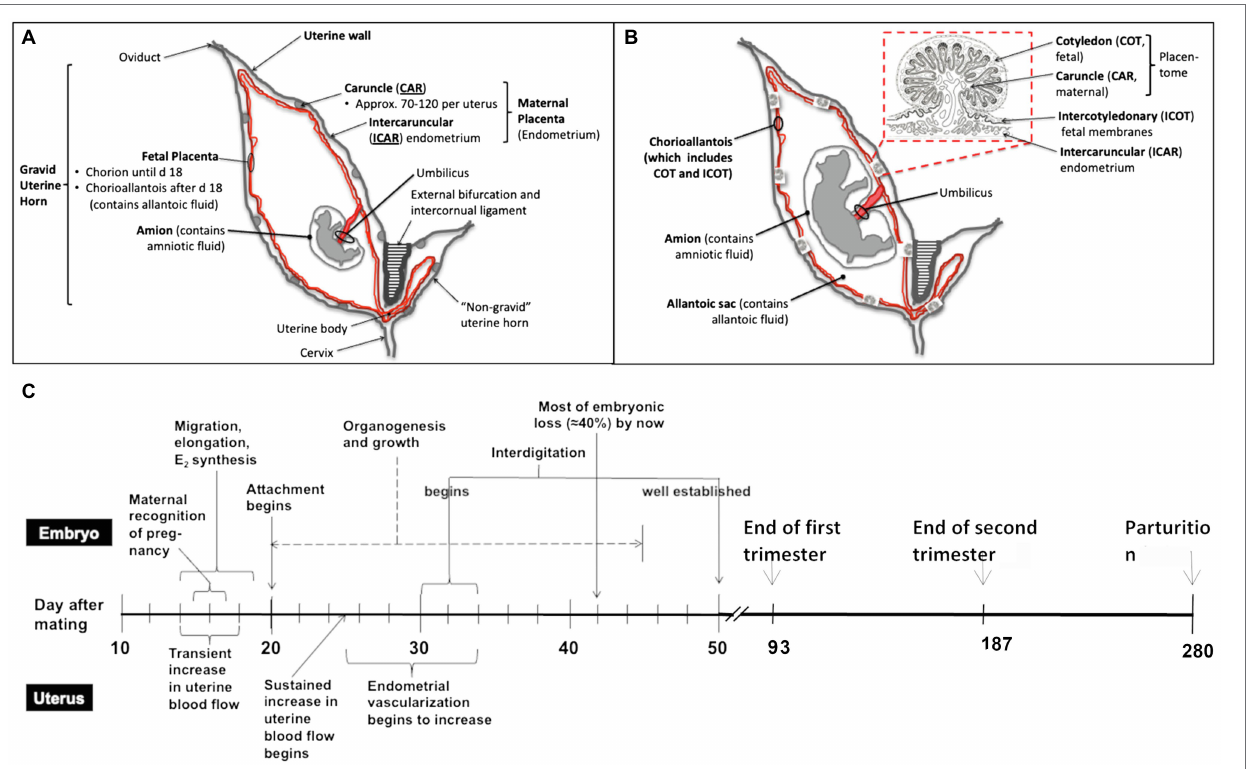
FIGURE 1 | Schematic overview of the bovine reproductive tract, different developmental stages of utero-placenta and fetal development ( A , day 25–30 after mating; B , mid to late pregnancy), and the timeline of placental and embryonic/fetal development during the entire pregnancy in cattle (C) . Timeline modified from Caton et al. (2020). As shown in (A) and (B) , the fetus and placenta (both the maternal and fetal portions) are contained in the gravid uterine horn (normally present in only one uterine horn as cattle typically have singleton pregnancies). Over the course of pregnancy, from early (A) to mid to late (B) pregnancy, the fetus develops (organogenesis is completed by about day 45–50 of pregnancy), and the fetal organs and placenta grow and mature. As mentioned, the placenta consists of both fetal (cotyledon and intercotyledonary fetal membranes) and maternal (caruncle and intercaruncular endometrium)